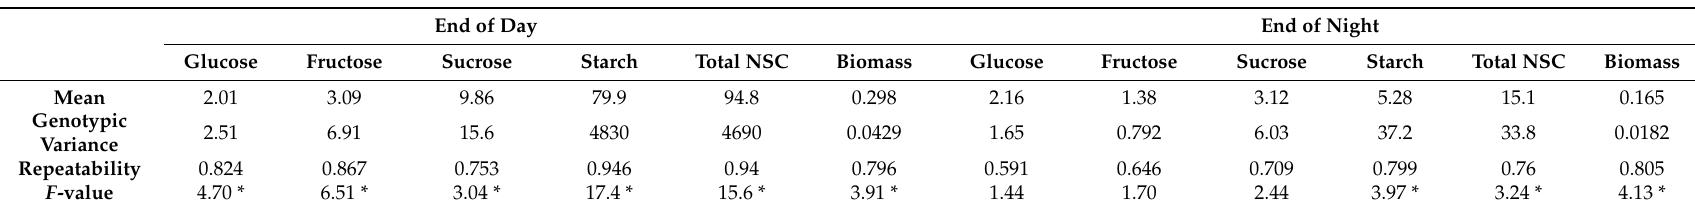
Table 1. Mean, estimate of genotypic variance, estimate of repeatability, and F -values as determined by ANOVA for WSC contents, starch content, total non-structural carbohydrate (NSC) content, and biomass DW: dry weight). * p <